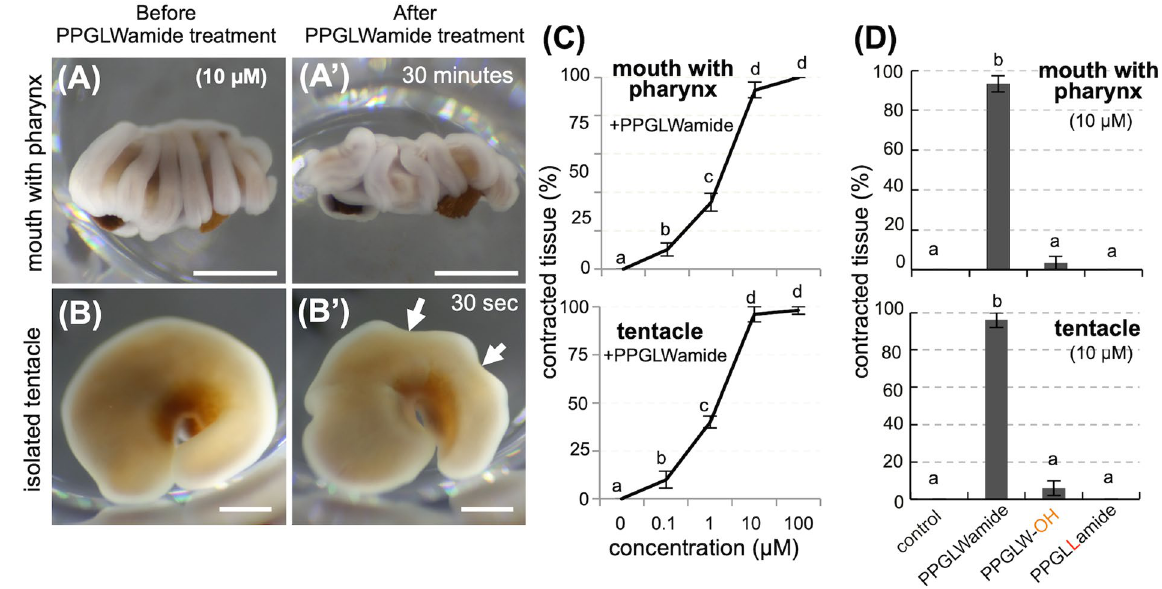
Figure 5. Effects of PPGLWamide peptides on isolated pieces of the mouth (with the pharynx) and tentacles. ( A ) An isolated piece of mouth with the pharynx before treatment. (A’) Identical tissue at 65 minutes after treatment with 10 μ M PPGLWamide peptide. ( B ) An isolated tentacle before treatment. (B’) Identical tissue at 1 minute after treatment with 10 μ M PPGLWamide peptide. Note that the tissues treated with PPGLWamide peptide exhibited contraction. Arrows indicate dents observed on the tentacle. Scale bars = 1 mm. See also Fig. S6 and S7. ( C ) The effects of PPGLWamide peptide (0-100 μ M) on the isolated piece of mouth with the pharynx. ( D ) The effects of treating the isolated piece of the mouth with control (vehicle, H 2 O), 10 μ M PPGLWamide, 10 μ M PPGLW-OH, or 10 μ M PPGLLamide peptide. For ( C , D ), the percentages of isolated tissues exhibiting a distinct contraction after treatment (contracted tissues) were determined. Data are shown as the mean ± SE (n = 5 experiments). Groups with different lower case letters are significantly different (P <